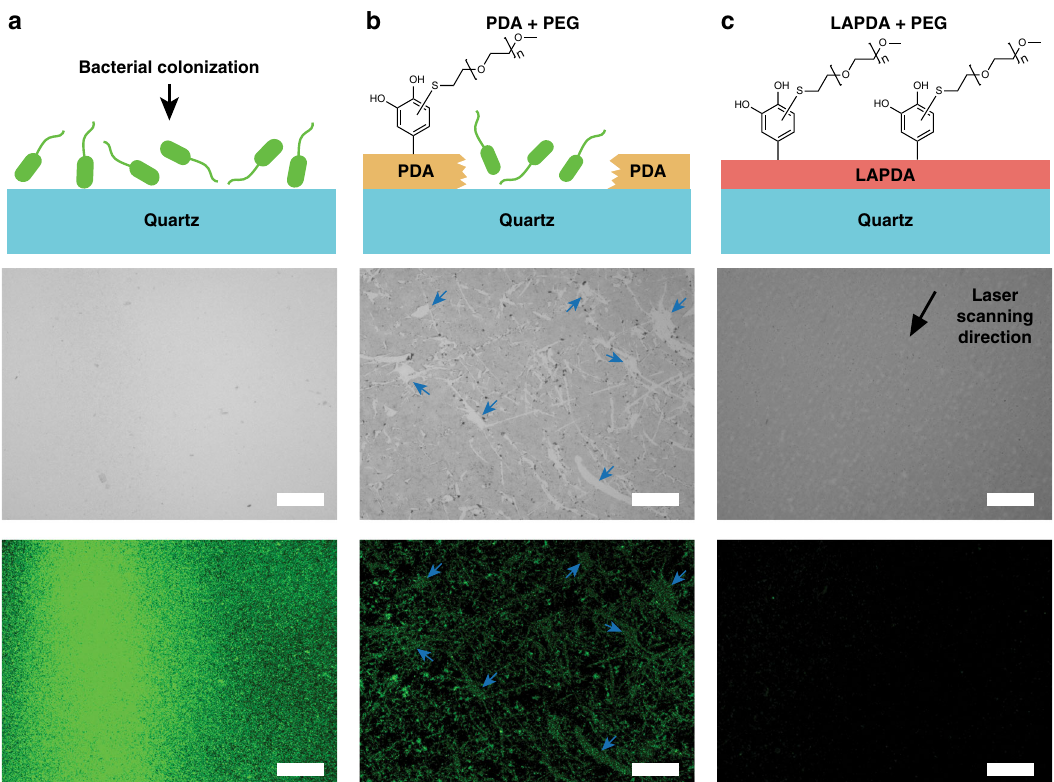
Fig. 4 Preserved catechol functionality in LAPDA. Antifouling effect on a bare quartz, b PEGylated PDA, and c PEGylated LAPDA. Schematics on top illustrate bacterial colonization behavior ( E. coli .) on the surfaces. Middle and bottom images are corresponding bright- fi eld and fl uorescence images, respectively. The blue arrows indicate bacterial accumulation on sites of mechanical damage in the PEGylated PDA coating. The scale bar is 200 µ